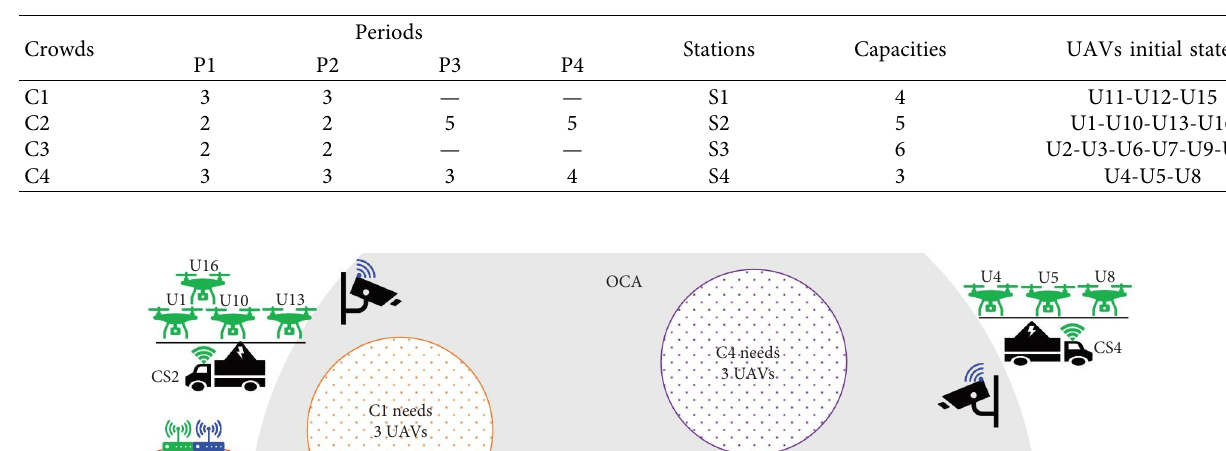
Table 1: Illustrative